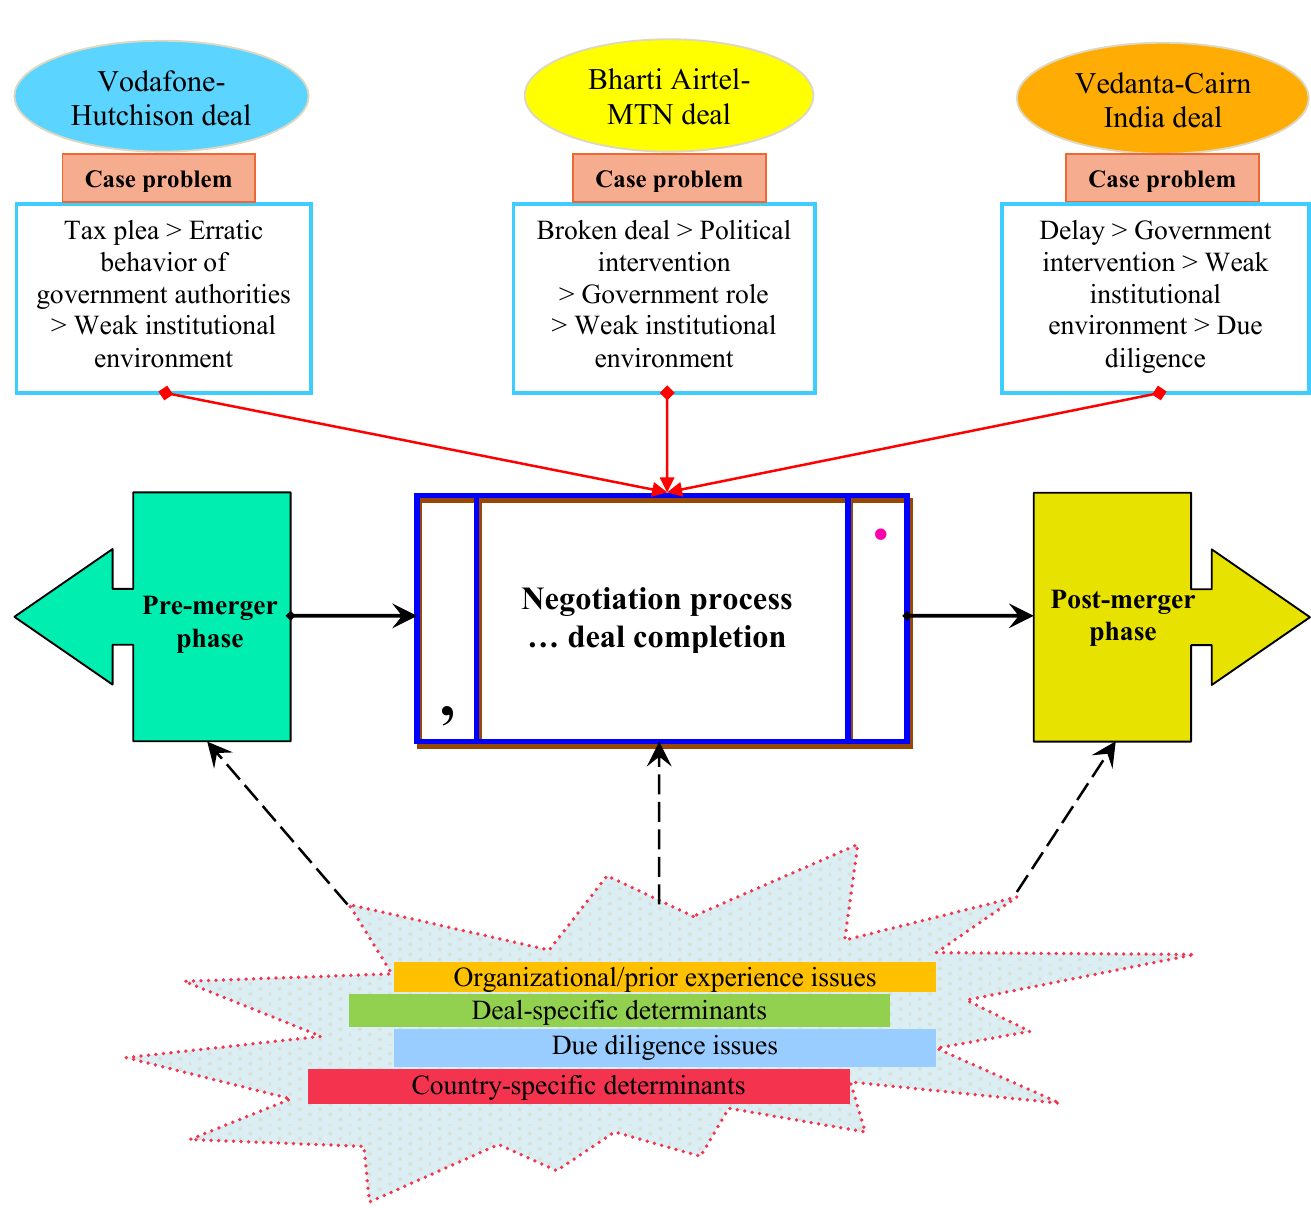
Fig. 1 Determinants of the cross-border inbound deal completion across